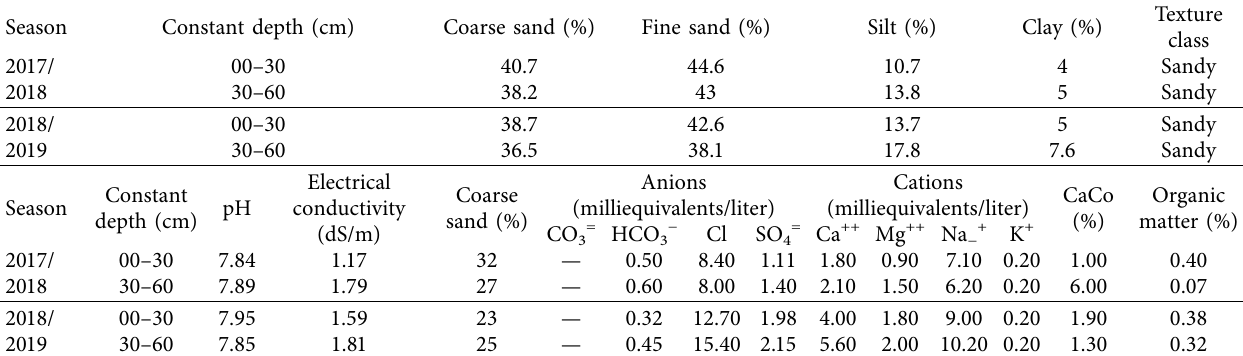
Figure 1: The data of maximum temperature (TMax ° C), minimum temperature (TMin ° C), and average relative humidity (RH%), obtained from the weather station installed at the experimental station of the National Research Centre, Nubaria, shows the climatic data of the experimental site during the growing season. Table 1: Physical, chemical, and nutritional analysis of the experimental